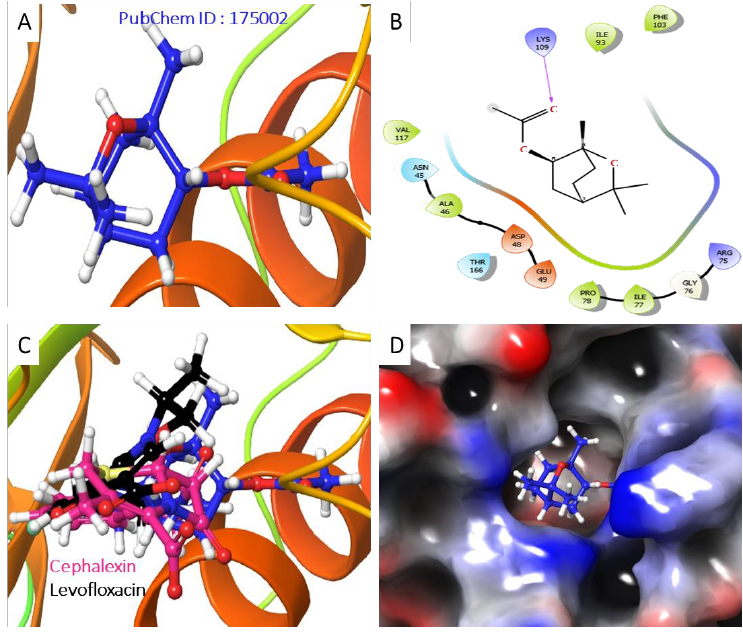
Figure 9. Analysis of the best-predicted docking pose of 175002. ( A ) 3D representation of the 1KIJ– 1,3,3-trimethyl-2-oxabicyclo[2.2.2]octan-6-ol complex. ( B ) 2D interaction diagram of the 1KIJ–1,3,3- trimethyl-2-oxabicyclo[2.2.2]octan-6-ol complex. ( C ) 3D representation of the 1KIJ–1,3,3-trimethyl- 2-oxabicyclo[2.2.2]octan-6-ol complex as superimposed with standard levofloxacin (green back- bone). ( D ) Hydrophobic surface representation of 1KIJ when complexed with 1,3,3-trimethyl-2-ox- abicyclo[2.2.2]octan-6-ol as shown in Figure 9.